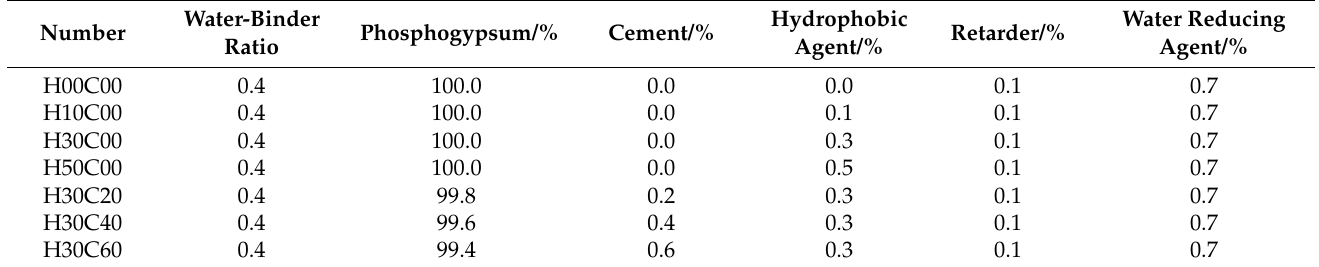
Table 2. Mix design of modified